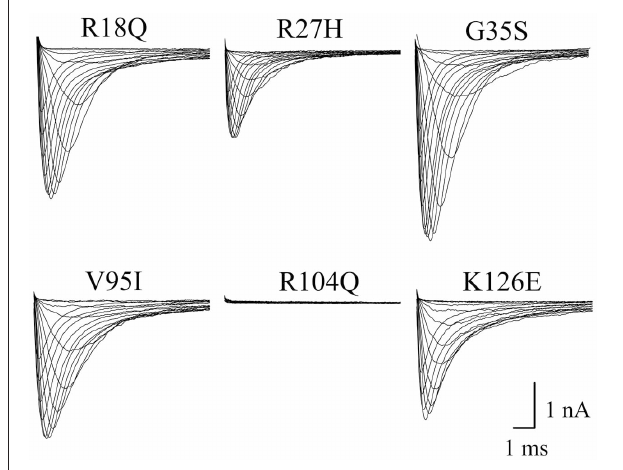
* indicates p < 0.05 vs. hNa v 1.5.